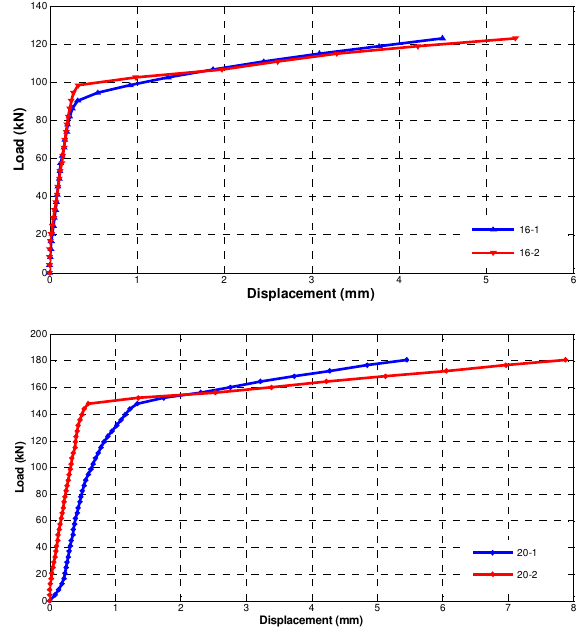
Figure 4. Displacement-Load Curves